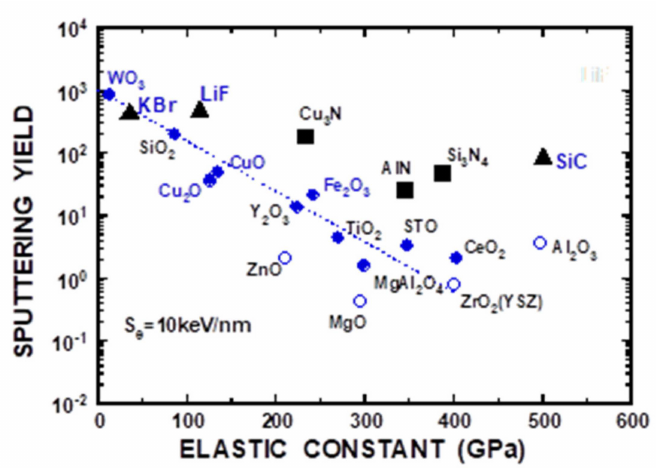
Figure 12. Sputtering yield at S e = 10 keV/nm vs. elastic constant. Sputtering yield of TiN (present result), LiF from [62] and others from [56]. Dotted line is a guide for eyes for the most abundant available data of oxides (o, •